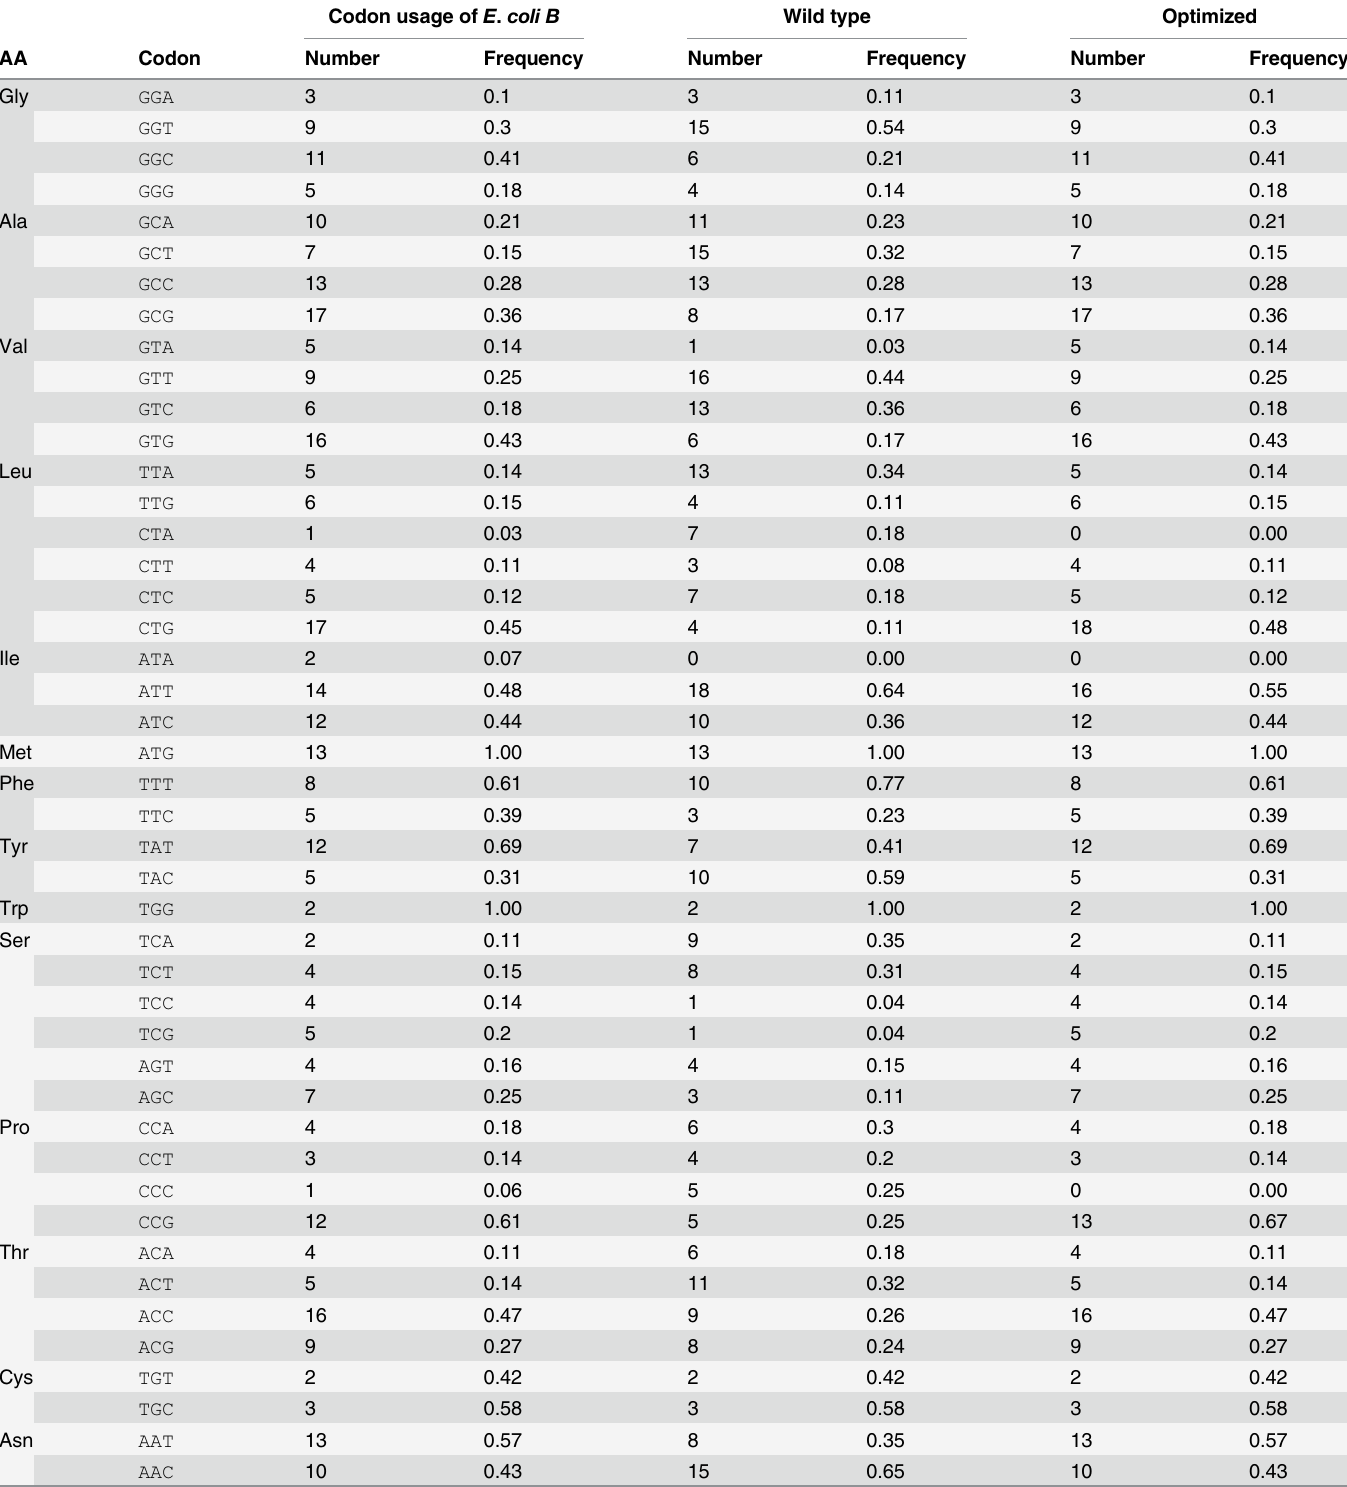
Table 2. Codon usage of wild type and optimized